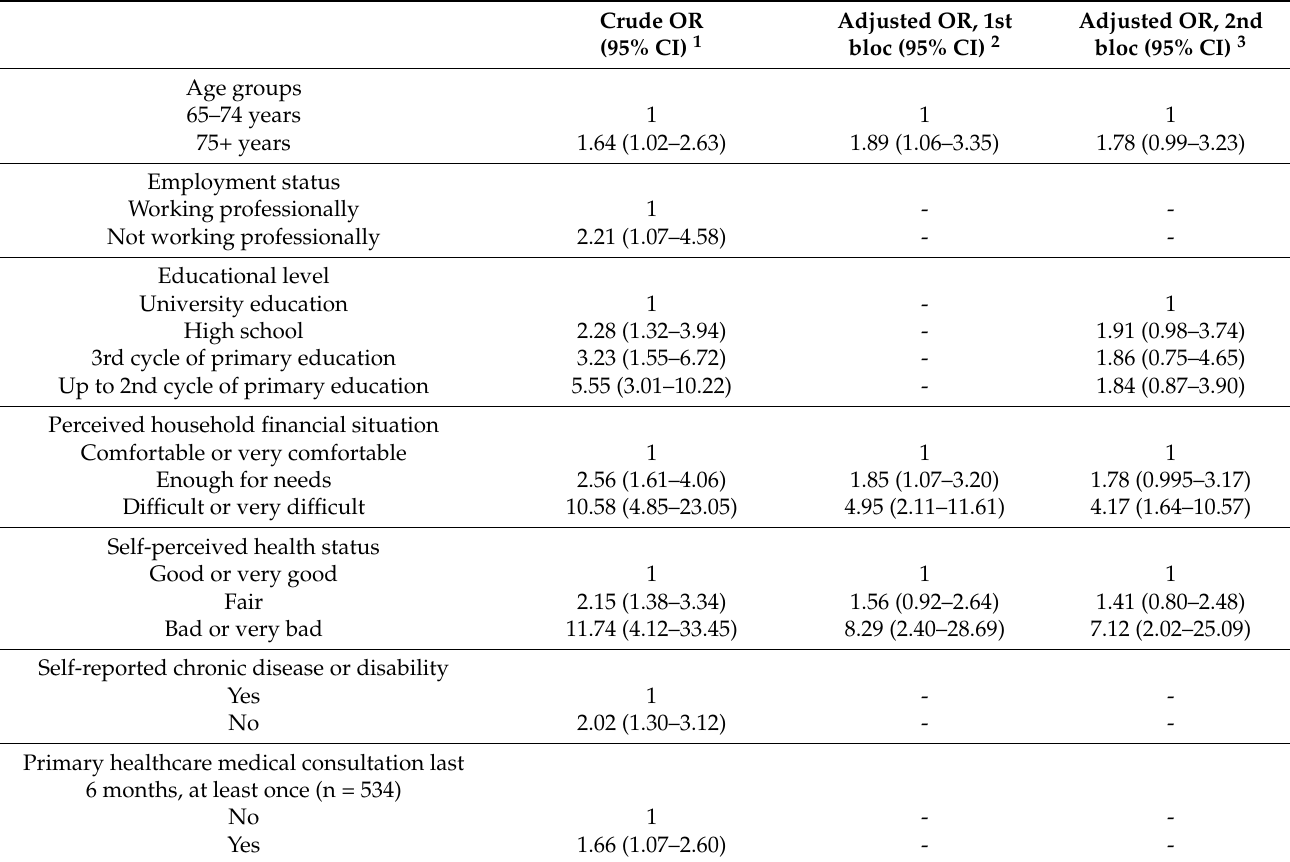
Table 3. Multivariate logistic regression analysis to predict limited general health